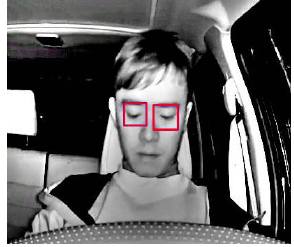
Figure 5. Failure to detect pupils.